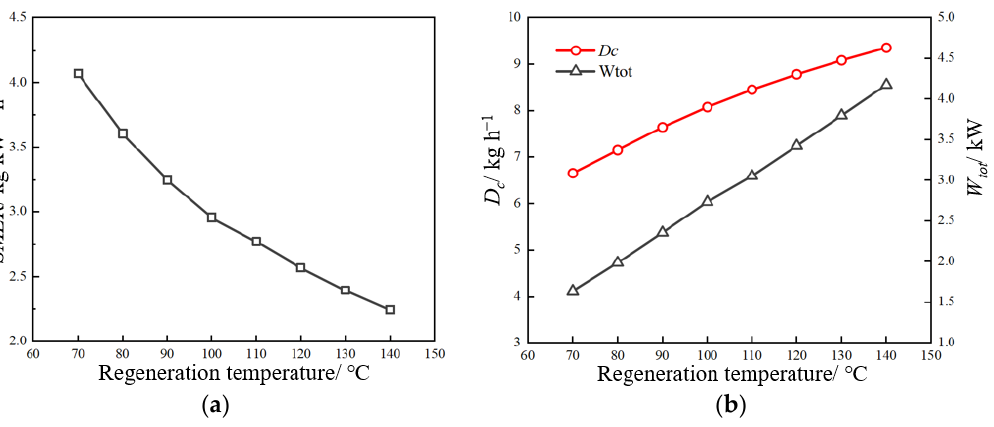
Figure 6. The effects of regeneration temperature on performance . ( a ) 𝑆𝑀𝐸𝑅 . ( b ) 𝐷 𝑐 and 𝑊 𝑡𝑜𝑡 .